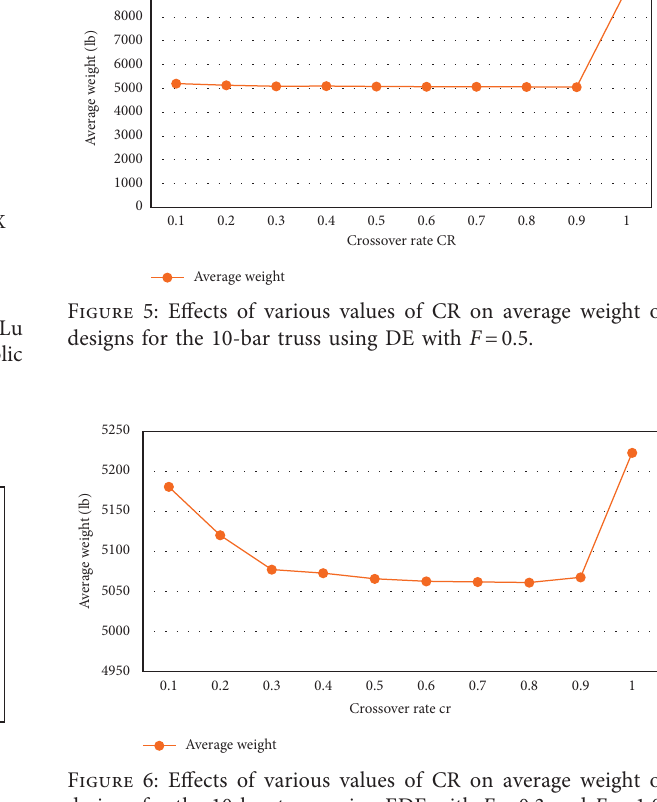
Figure 4: Effects of various values of F on average weight of designs for the 10-bar truss using DE with CR � 0.1.